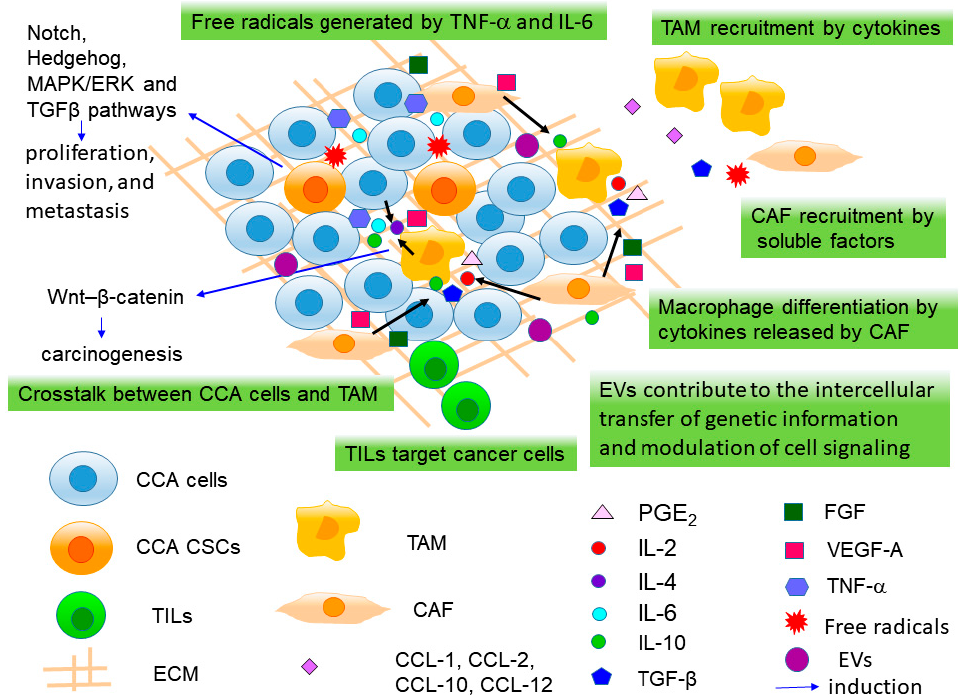
Figure 1. The tumor microenvironment (TME), ‘Cancer stem cell (CSC) niche’ of cholangiocarcinoma (CCA). The TME contains cancer-associated fibroblasts (CAFs), cancer cells / CSCs, tumor-associated macrophages (TAMs), tumor-infiltrating lymphocytes (TILs), and the extracellular matrix (ECM). TAMs are recruited into the TME by chemokines, MCP-1 / CCL2, C-X-C motif chemokine ligand (CXCL)1, CXCL10 and SDF-1 / CXCL12, secreted by tumor cells or other stromal cells. When infiltrating into TME, monocytes di ff erentiate into M2 macrophages upon stimulation with soluble factors, prostaglandin E 2 (PGE 2 ), and cytokines, interleukin (IL)-2, IL-10 and transforming growth factor- β 1 (TGF- β 1) released by CAF and other inflammatory cells. In the crosstalk between TAMs and CCA cells, matrix metalloproteinases (MMPs), IL-4, IL-6, IL-10, vascular endothelial growth factor-A (VEGF-A), tumor necrosis factor- α (TNF- α ) and TGF- β were secreted by lipopolysaccharide-activated TAMs. CAFs are recruited into the tumoral area and are activated by a variety of soluble mediators produced by both tumor cells, and the multiple inflammatory cells, such as platelet-derived growth factor (PDGF-D), TGF- β , reactive oxygen species (ROS) and FGF-2. CAF further recruit inflammatory cells, monocytes, macrophages, and endothelial cells to the tumor reactive stroma (TRS), through the secretion of VEGF, FGF, MCP-1 / CCL2, SDF-1 and CXCL-14. TILs include CD8 + cytotoxic T lymphocytes, cytokine-secreting CD4 + T helper lymphocytes (Th), Forkhead box P3 (FoxP3) + T leukocyte immunosuppressive regulators / regulatory T cells (Tregs), and B lymphocytes. TILs target cancer cells, and thus serve as a primary defence against cancer. T cell activation is tightly regulated by immune checkpoint pathways. TNF- α and IL-6 promote the generation of free radicals causing damage to DNA, resulting in genetic mutations and finally lead to tumor initiation. Wnt / β -catenin, Notch, Hedgehog, mitogen-activated protein kinase (MAPK) / extracellular signal-regulated kinase (ERK) and TGF β pathways associated with cell growth dysregulation, invasion, and metastasis were activated surrounding CSCs. Extracellular vesicles (EVs) play as carriers for the intercellular transfer of genetic information and modulation of cell signaling of cancer